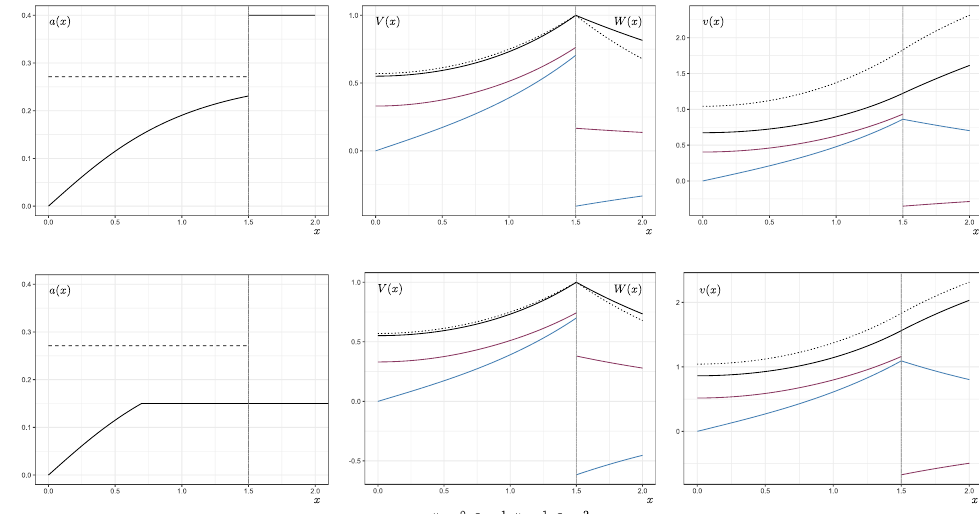
Figure 2. Optimal strategy inducing function a ( x ) , optimal Laplace transform of the first passage through d from below, V ( x ) , and from above, W ( x ) , and expected discounted time in drawdown v ( x ) (solid, black, from left to right ). Top: a = 0.4. Bottom: a =